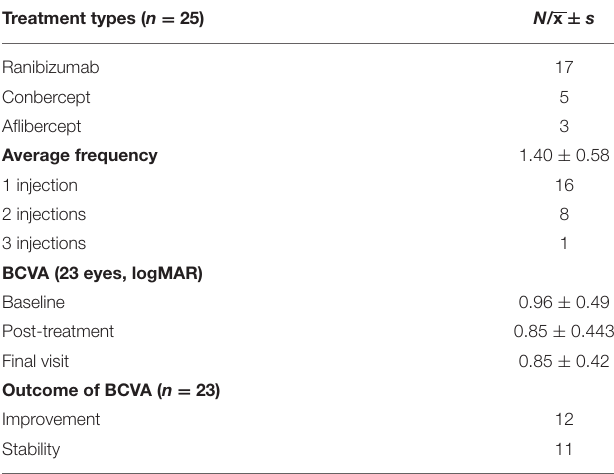
TABLE 4 | Treatment